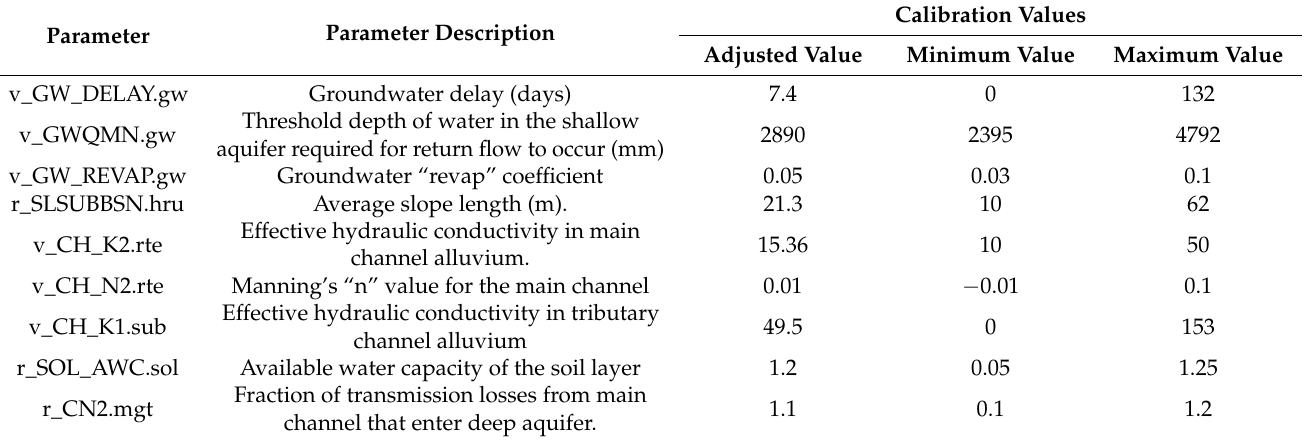
Table 1. Sensitive parameters in surface flow calculations and calibrated